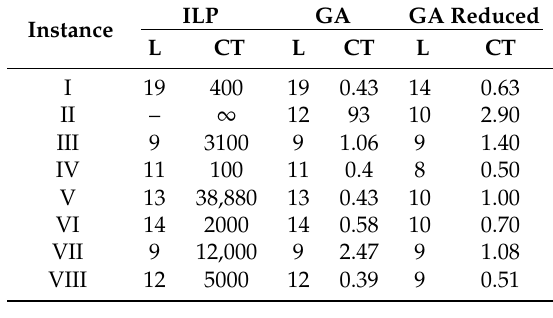
Table 7. Genetic Algorithm and Exact Solution.